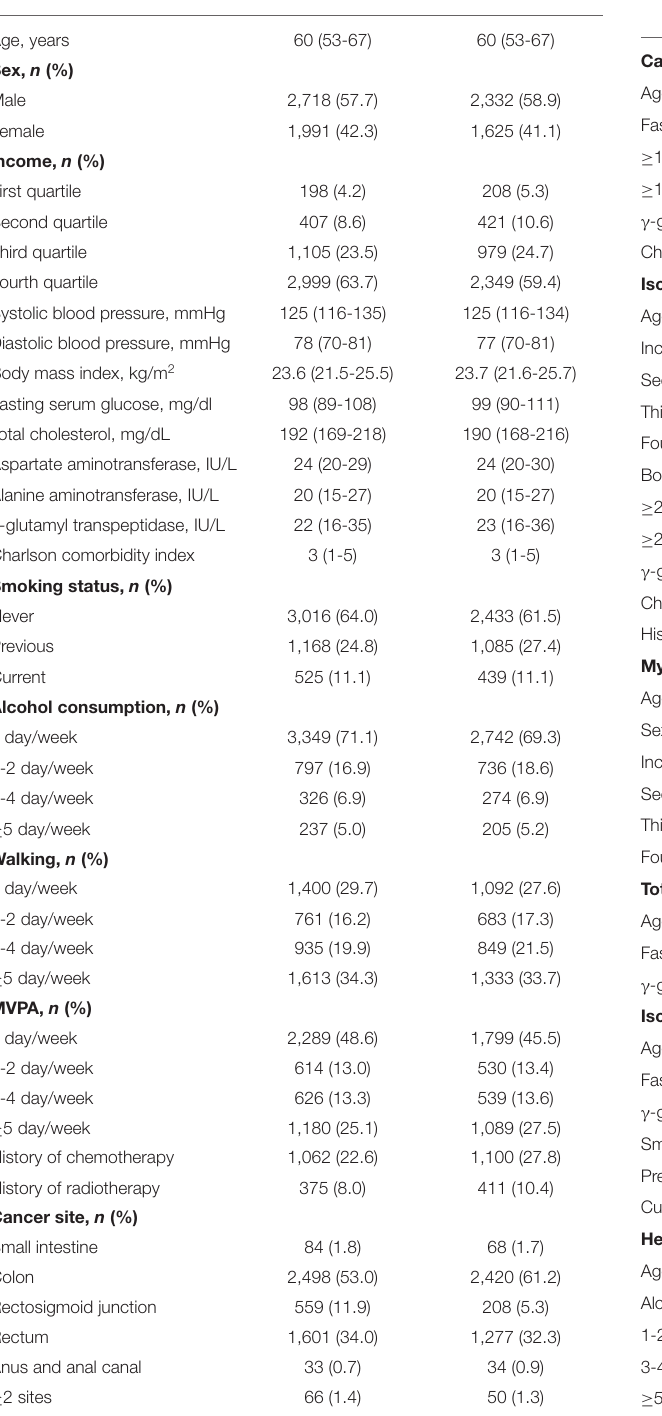
TABLE 1 | Baseline characteristics of the colorectal cancer survivors. TABLE 2 | Multivariate analysis of significantly predictive factors for cardiovascular